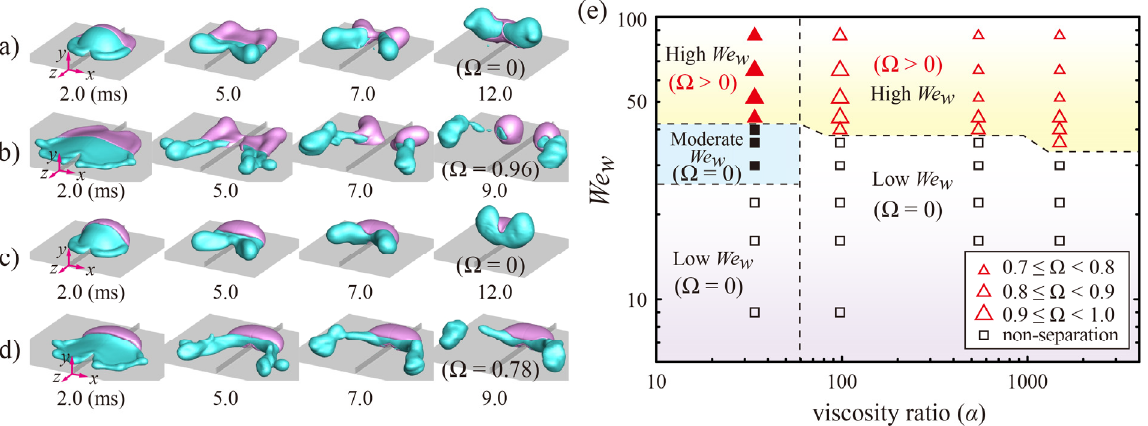
Figure 4. Bouncing characteristics depending on the impact velocity and viscosity ratio at D 0 = 3.0 mm. ( a – d ) Shape evolutions of the drops impinging at ( a , b ) We w = 22 and 65 under the viscosity ratio of α 1 , respectively, and ( c , d ) We w = 22 and 65 under the viscosity ratio of α 3 , respectively. ( e ) Regime map of We w as a function of the viscosity ratio. Triangle and square symbols in the map indicate separation/non-separation situations between W- and G-parts, respectively; filled and open symbols represent fragmentation/non-fragmentation situations for G-part, respectively. The Weber numbers can be characterized into low-, moderate-, and high- We w regimes for W-part.